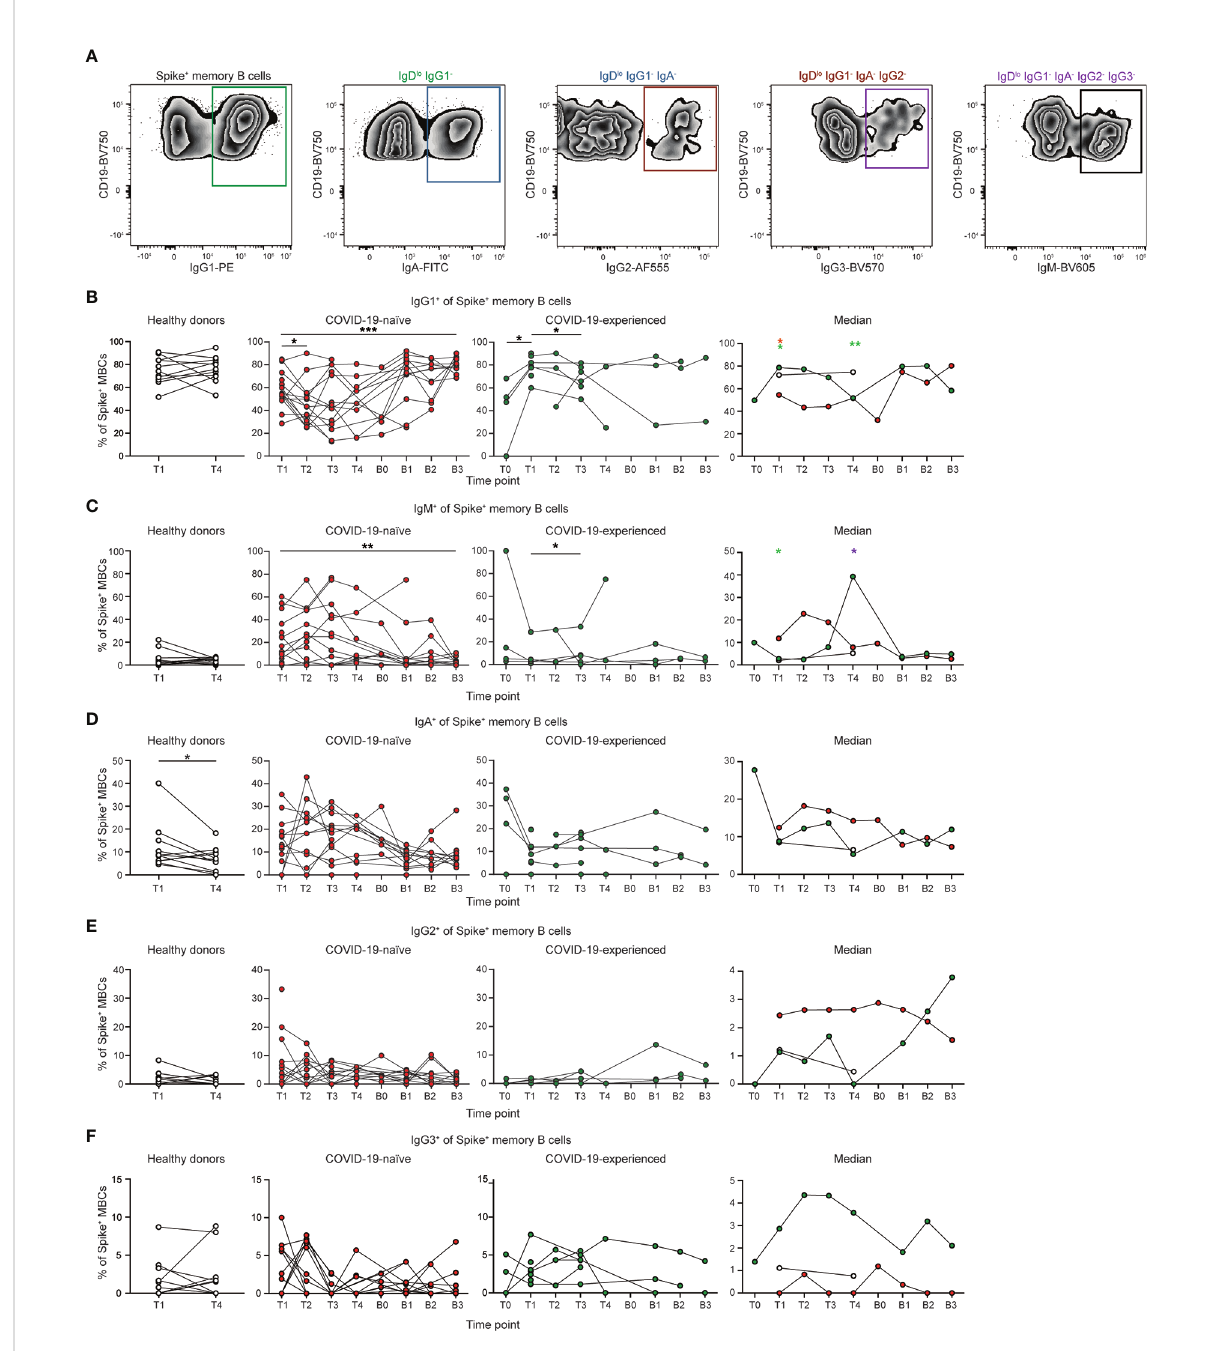
FIGURE 3 Spike-speci fi c memory B cells from COVID-19-naïve PAD patients display reduced IgG1 class switching following primary vaccination series. (A) Representative fl ow cytometry plots of the gating strategy used to identify the immunoglobulin subclass of Spike + memory (IgD lo CD20 + CD38 int-lo CD27 + ) B cells. Percentage of Spike + memory B cells that are (B) IgG1 + , (C) IgM + , (D) IgA + , (E) IgG2 + , and (F) IgG3 + in healthy donors (left, white), and COVID-19-naïve (middle left, red) and -experienced (middle right, green) PAD cohorts. Median percentage of B cells that comprise each population in all groups is shown on right. Statistical analyses in B-D were performed using a mixed effects model (for trends found between time points) or two-way ANOVA (for trends found between groups shown on the median graphs) with Fisher ’ s least signi fi cant difference testing. Signi fi cance testing between time points was limited to comparisons relative to T1. Above the median graphs, a green asterisk indicates a comparison between the COVID-19-naïve and healthy donor groups, an orange asterisk indicates a comparison between the COVID-19-naïve and -experienced groups, and a purple asterisk indicates a comparison between the COVID-19-experienced and healthy donor groups (* p < 0.05; ** p < 0.01; *** p < 0.001). See also Figure